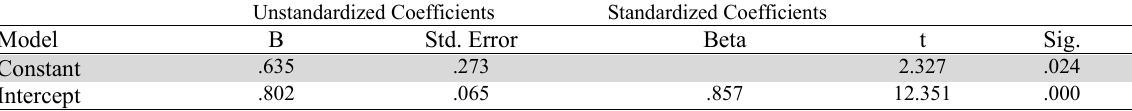
The results of the regression analysis Unstandardized Coefficients